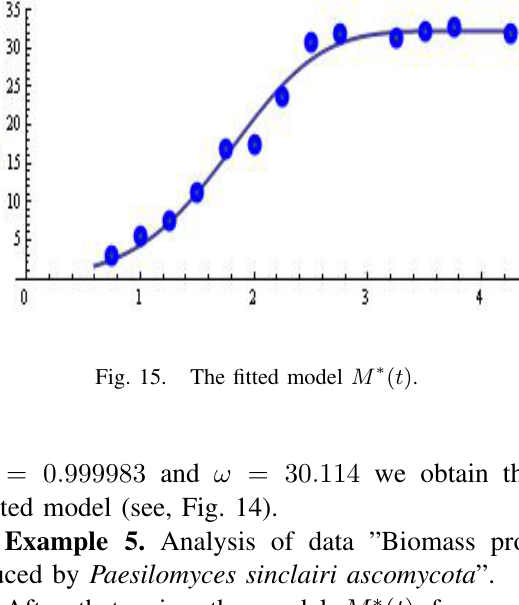
Fig. 15. The fitted model M ∗ ( t )